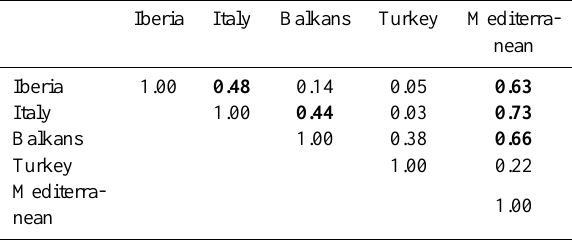
Table 1. Correlation coefficient values between averages of scPDSI time series for the entire Mediterranean basin and the four sub- domains. Values in bold are considered statistically significant, tak- ing into account the auto-correlation of the scPDSI index.